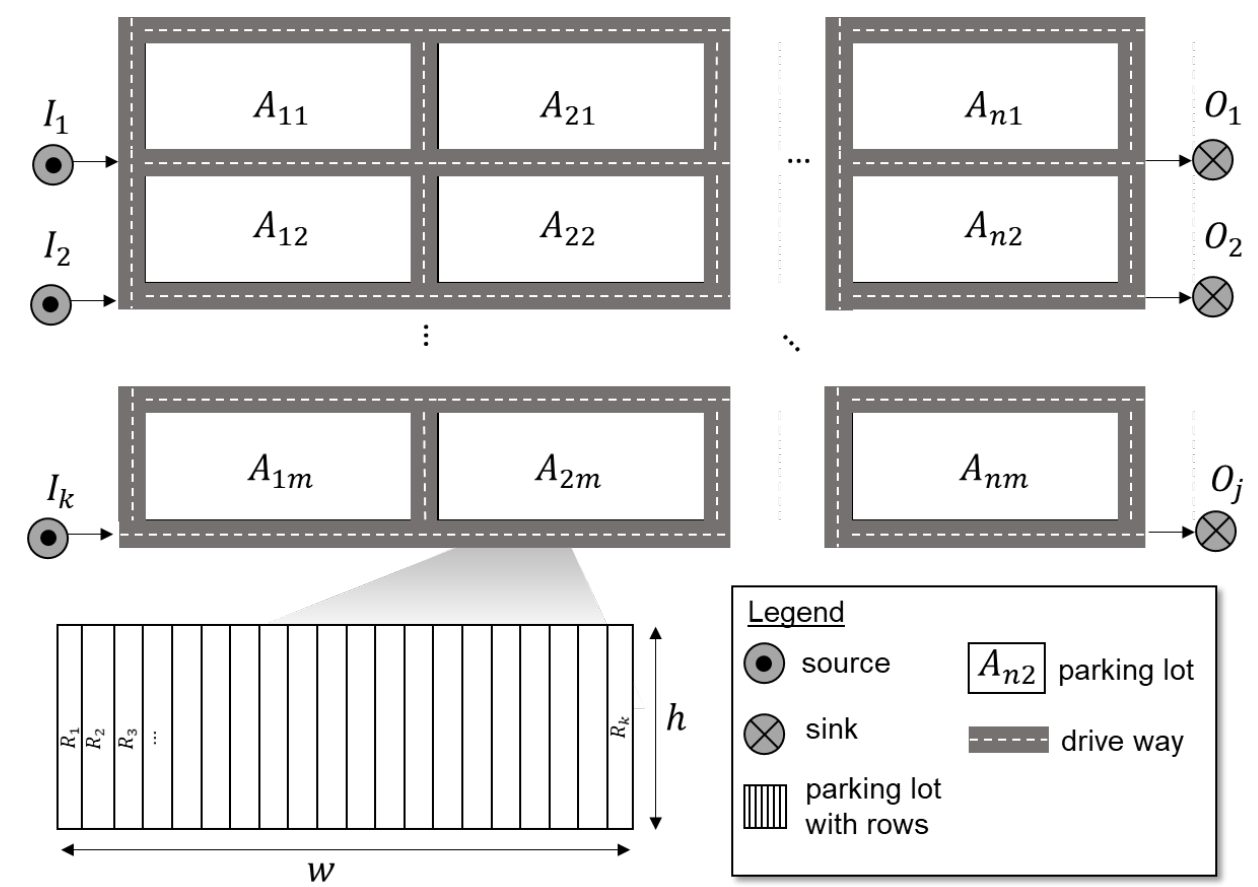
Figure 2. Generic automobile terminal scenario [12] .